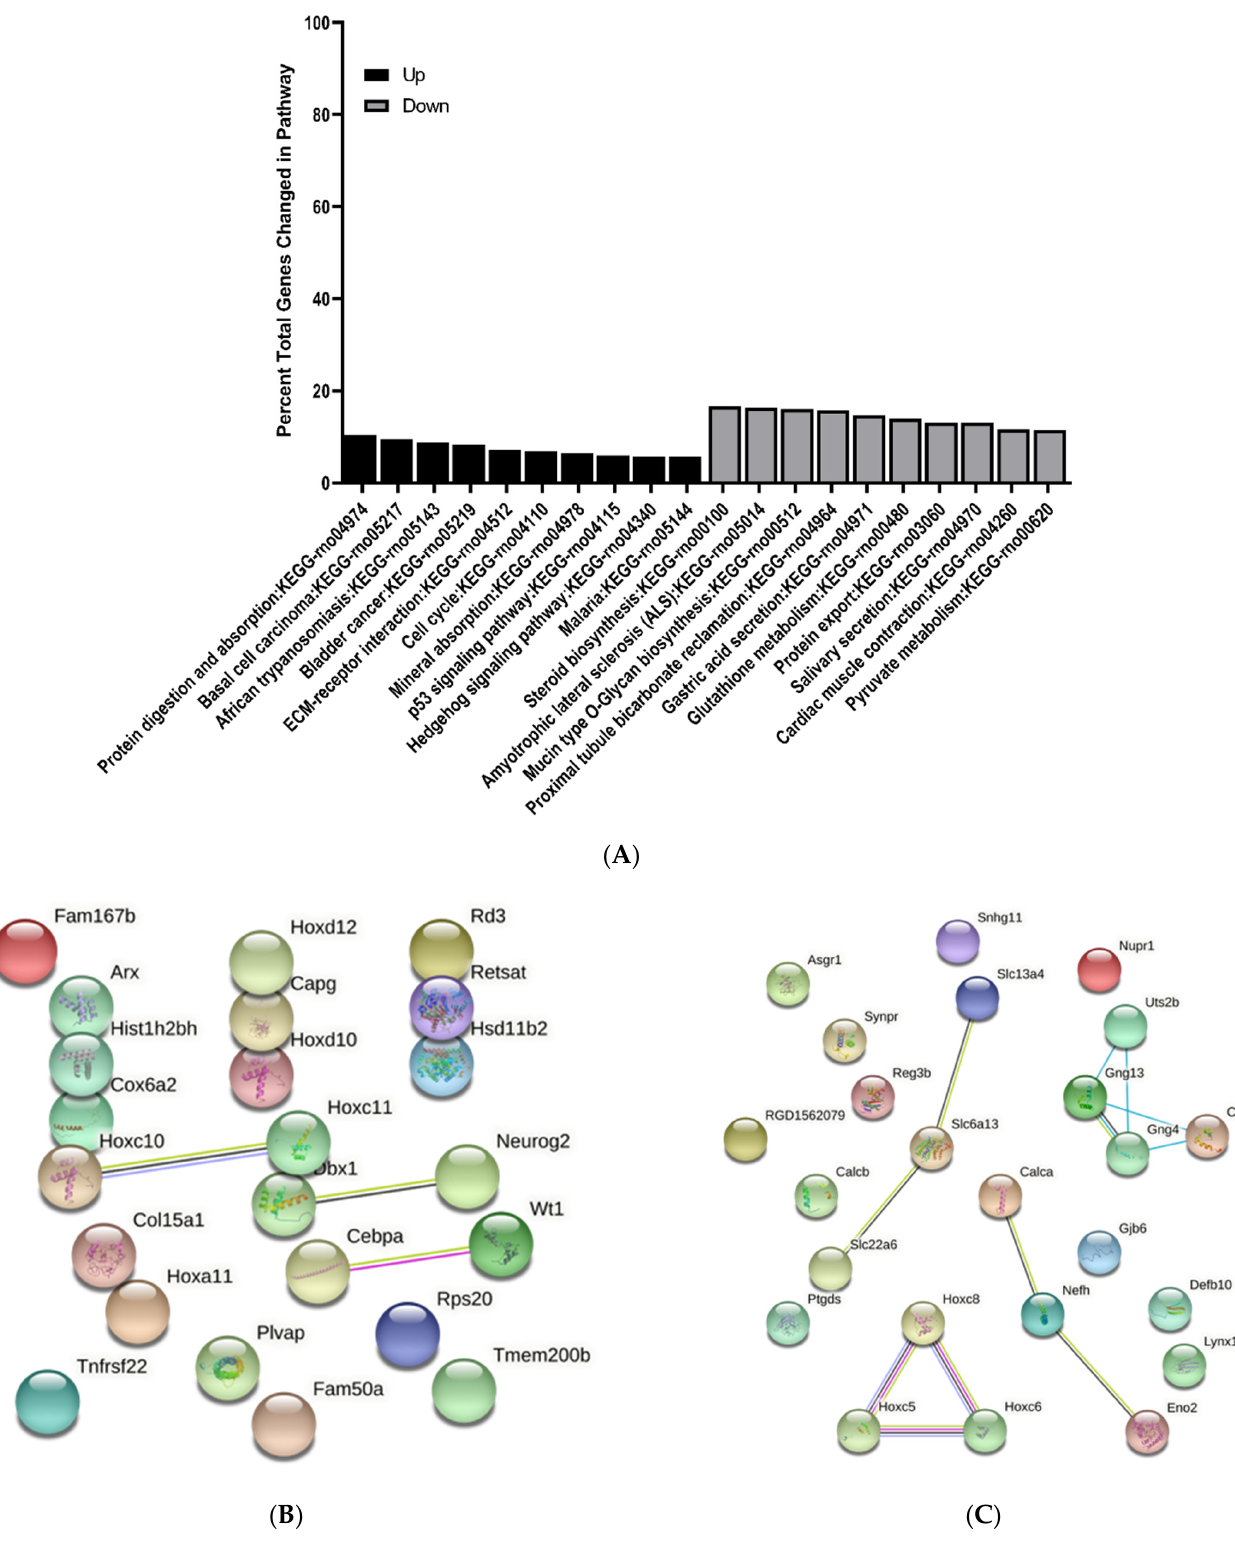
Figure 10. KEGG and protein–protein interaction network analysis of differentially expressed genes in the spinal cord of MMC and vehicle fetuses isolated at E17. ( A ) Top 10 KEGG pathways upregulated and downregulated as determined by percent total changed genes in each pathway. All pathways were greater than 1.5-fold change and p < 0.05. ( B , C ) Protein–protein interaction network analysis based on top 25 ( B ) upregulated and ( C ) downregulated differentially expressed genes.